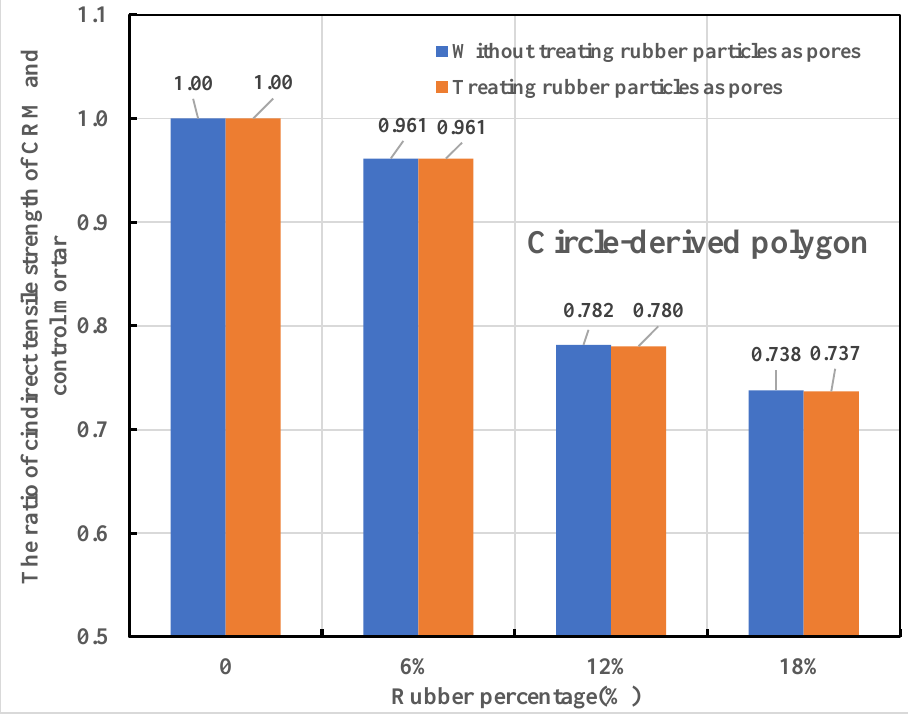
Figure 16. Changes in the indirect tensile strength of CRM models after treating rubber particles as pores.